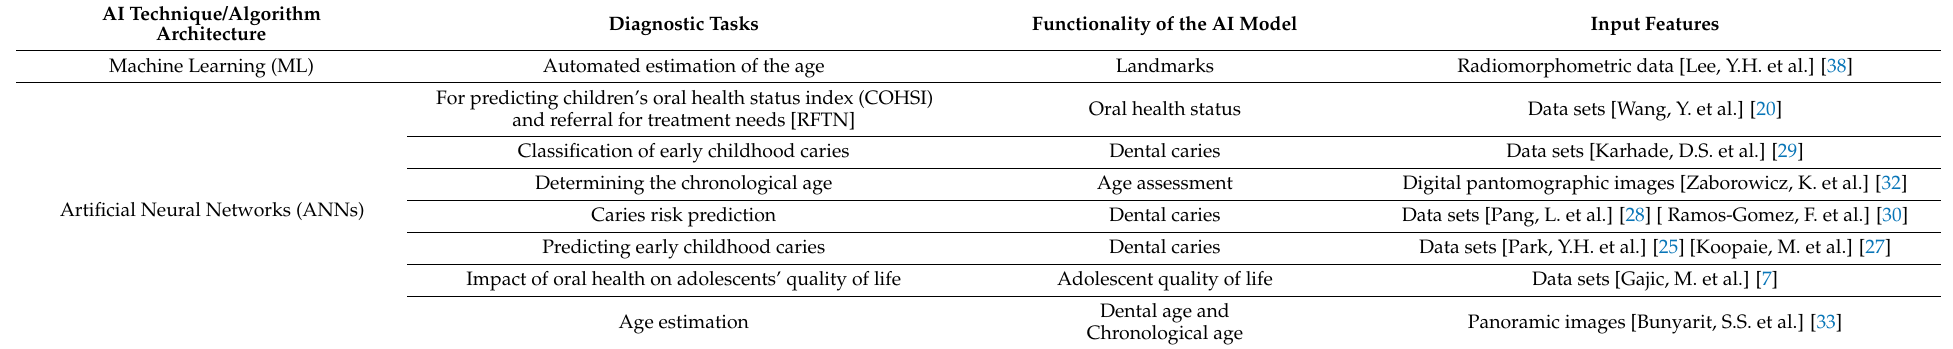
Table 2. Summary of AI models designed for different diagnostic